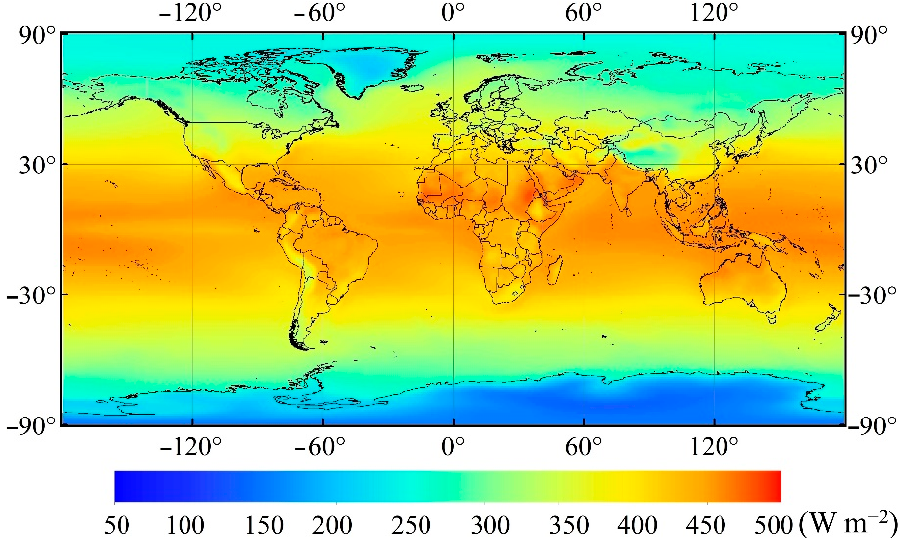
Figure 6. Spatial variation in the SULR estimations from the CMIP6 GCMs using the BMA method from 2000 to 2005 (in units of W m − 2 ).